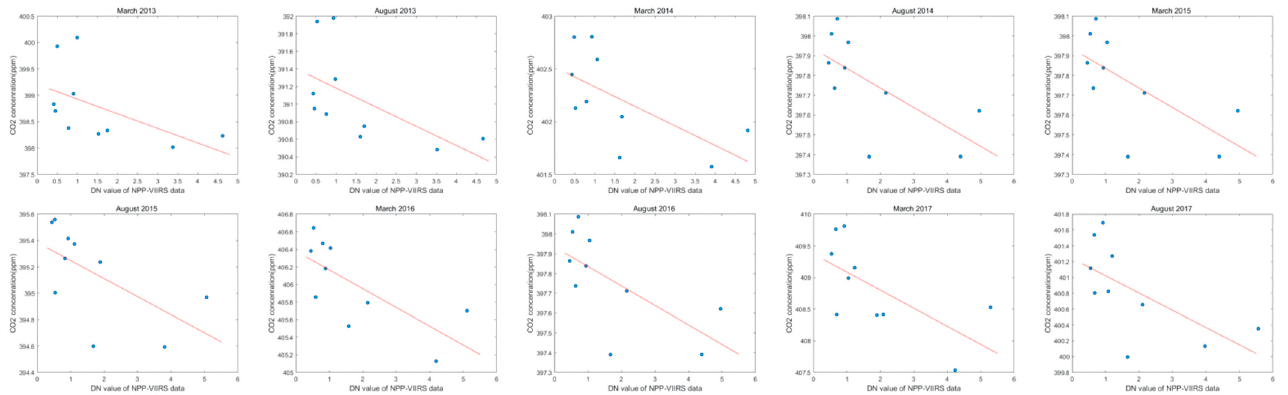
Figure A4. Correlation between monthly NL data and CO 2 concentration of cities in Beijing-Tianjin- Hebei region from 2013 to 2017.